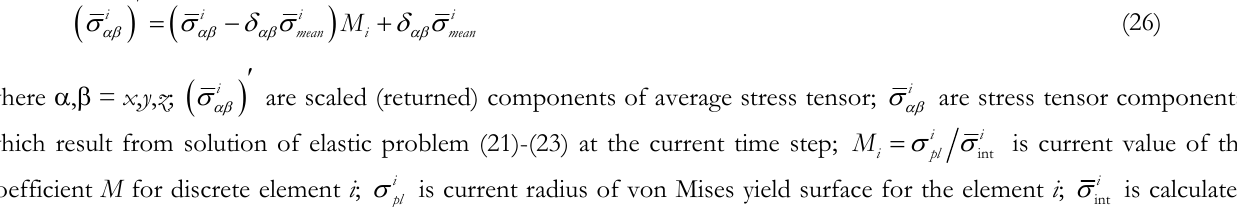
is a current value of yield stress (taking into account hardening),  pl